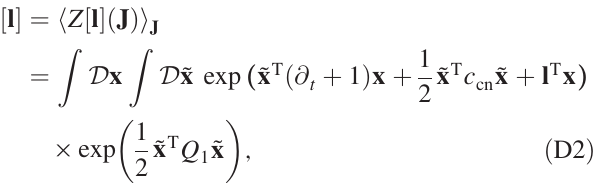
ffiffiffiffiffiffiffiffiffiffiffiffiffi p 1 − E ; ð C13 0